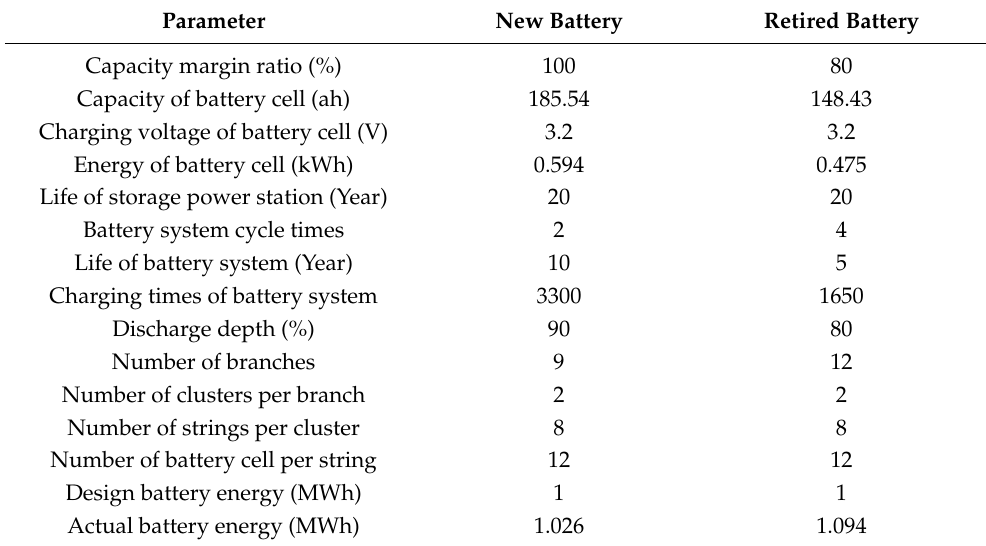
Table 6. Structural comparison of different battery systems in energy storage power